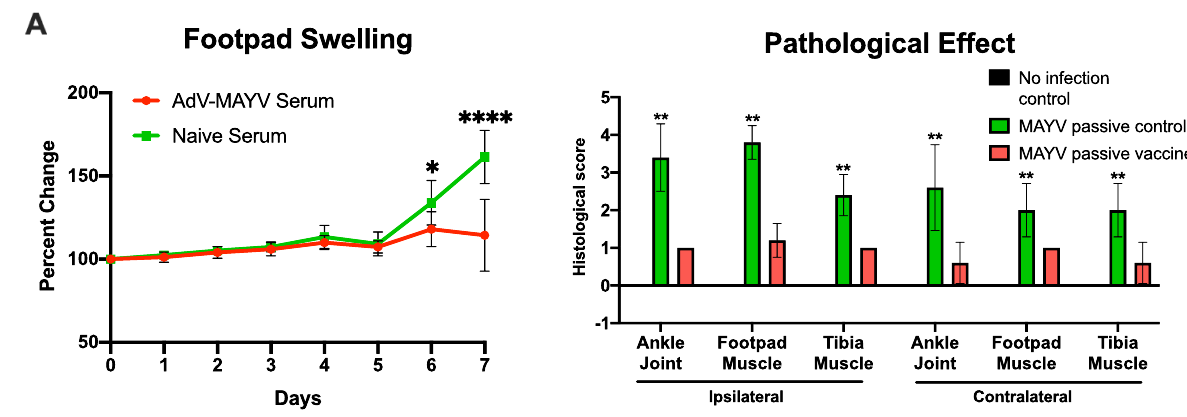
Fig 6. Passive Transfer of AdV-MAYV Immune Sera Protects Against Pathological Effects of Infection. Na ï ve or immune sera was passively transferred to groups of five-week-old female WT C57BL/6N mice one day prior to challenge with 10 4 PFU MAYV BeAr in the right hind limb footpad. A second group of na ï ve five-week-old female WT C57BL/6N were mock inoculated with PBS. (A) Footpad swelling was monitored by digital calipers throughout the experiment. Statistical analysis was performed by paired repeated measures ANOVA ( � P < 0.05, ���� P < 0.0001). (B) Whole hind legs were harvested at 7 dpi and sectioned for histopathology by hematoxylin and eosin staining. Tissue sections were scored on a 0–5 scale using the no infection control tissues as a baseline score: 0 absent (no lesions), 1 minimal (1~10% of tissues affected), 2 mild (11~25% affected), 3 moderate (26~50% affected), 4 marked (51~75% affected), 5 severe ( > 75% affected). Statistical analysis was performed by two-way ANOVA ( � P < 0.05, ���� P < 0.0001). Error bars represent SD.